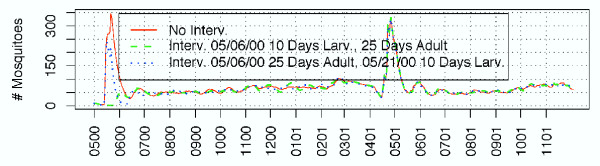
An. gambiae adult abundance with larval and adult control intervention